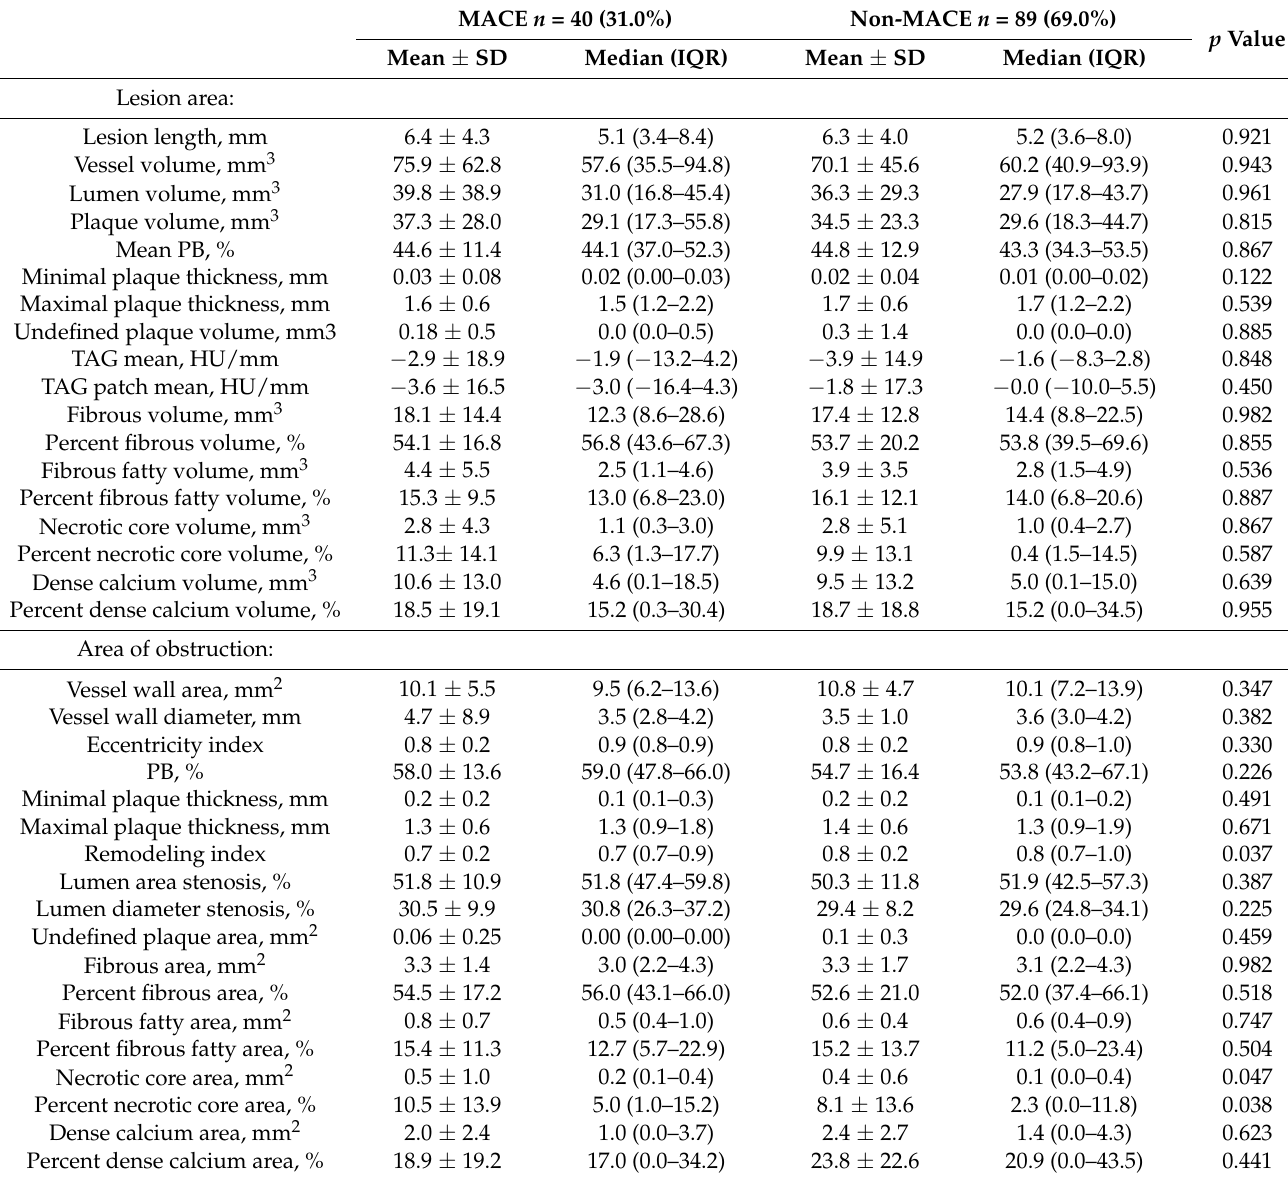
Table 2. Quantitative CCTA analysis findings of target